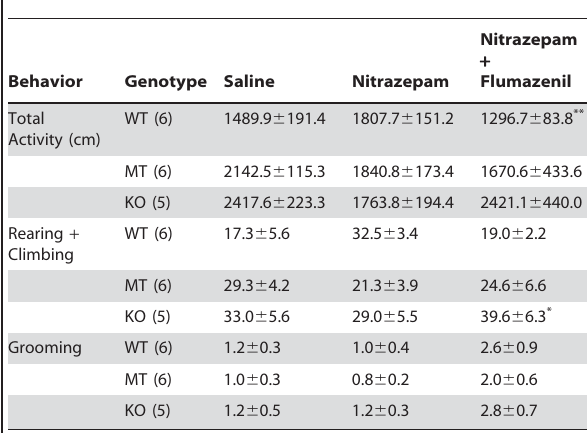
Table 1. Effects of nitrazepam (1 mg/kg) and flumazenil (10 mg/kg) on general behaviors in